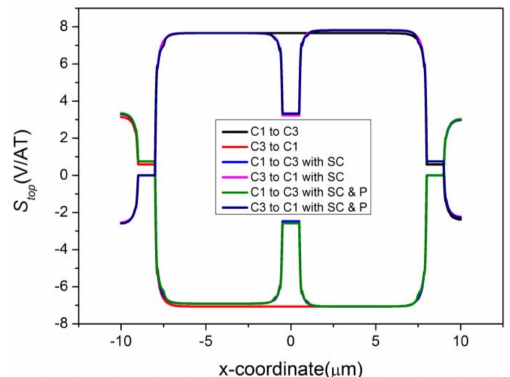
Figure 6. Effects of sensing contact and P-type layers on S top . SC represents the sensing contact and P represents the P-type